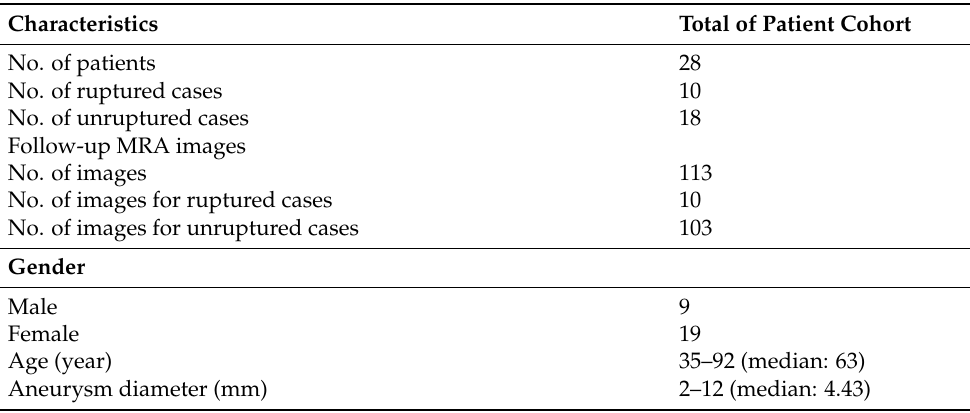
Table 1. Patient